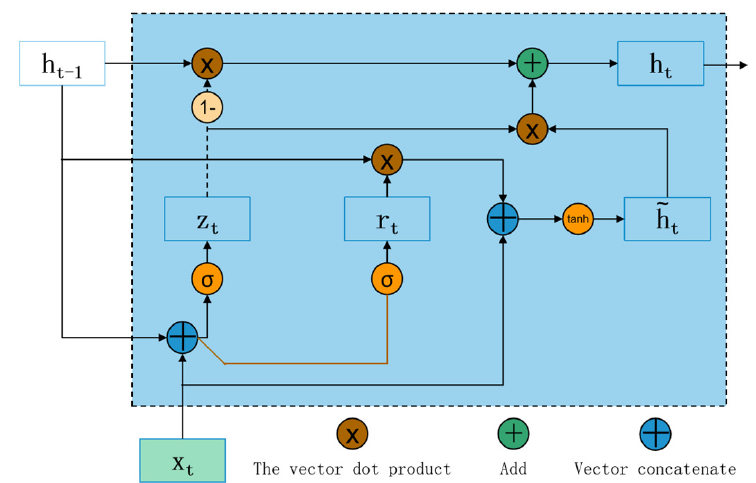
Figure 1. GRU unfolding structure.